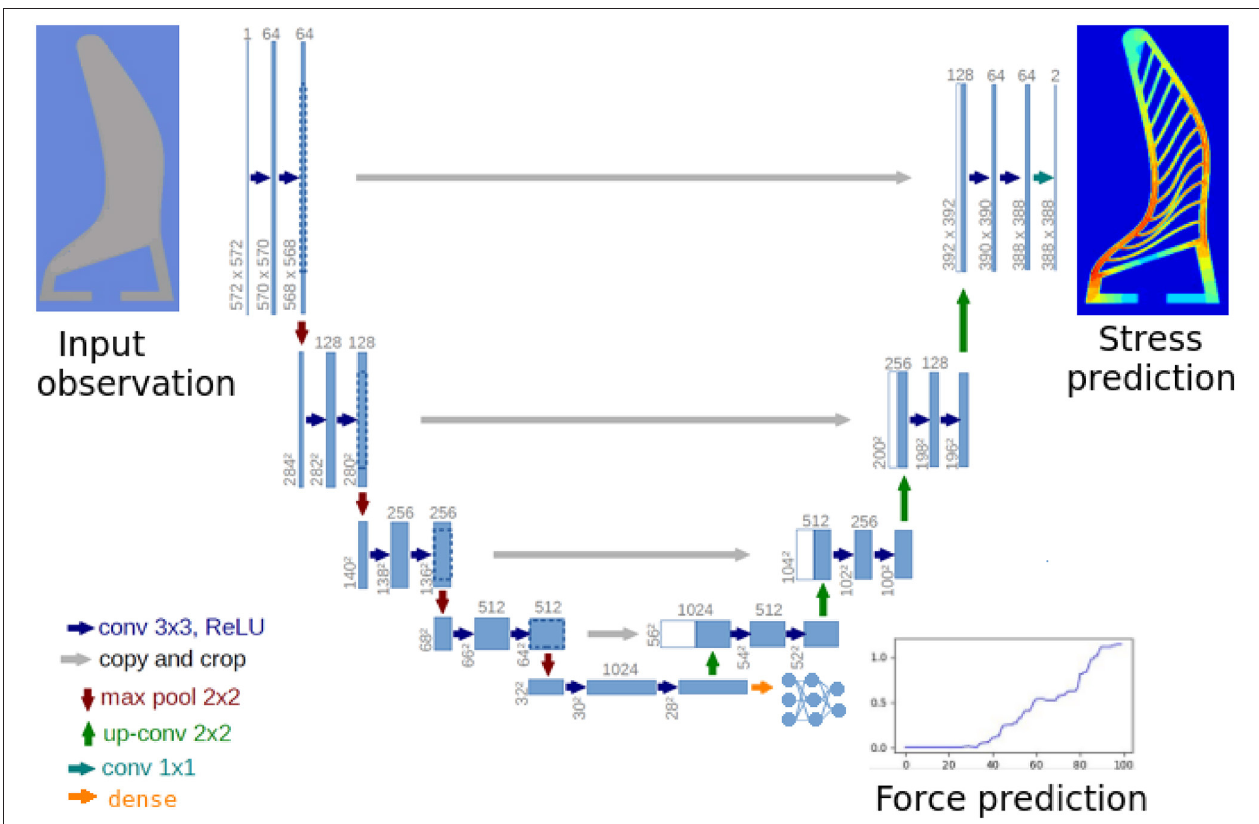
FIGURE 5 | Network architecture: the encoder and decoder follow similar architecture as U-net (Ronneberger et al., 2015) including the skip connections between encoder and decoder. We add an additional branch for decoding forces from the intermediate representation. The force decoder consist of a dense fully connected neural network of depth five layers. The entire network is trained in an end-to-end fashion by optimising the joint loss function (Equation 1).